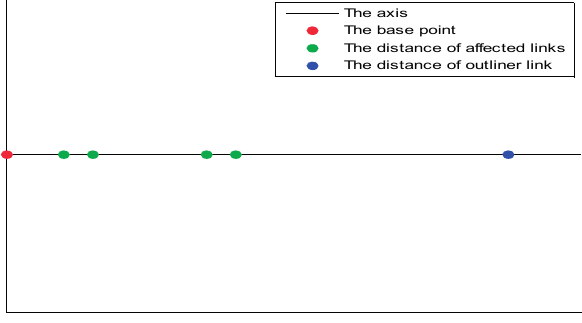
Figure 3. Distribution of the mapped